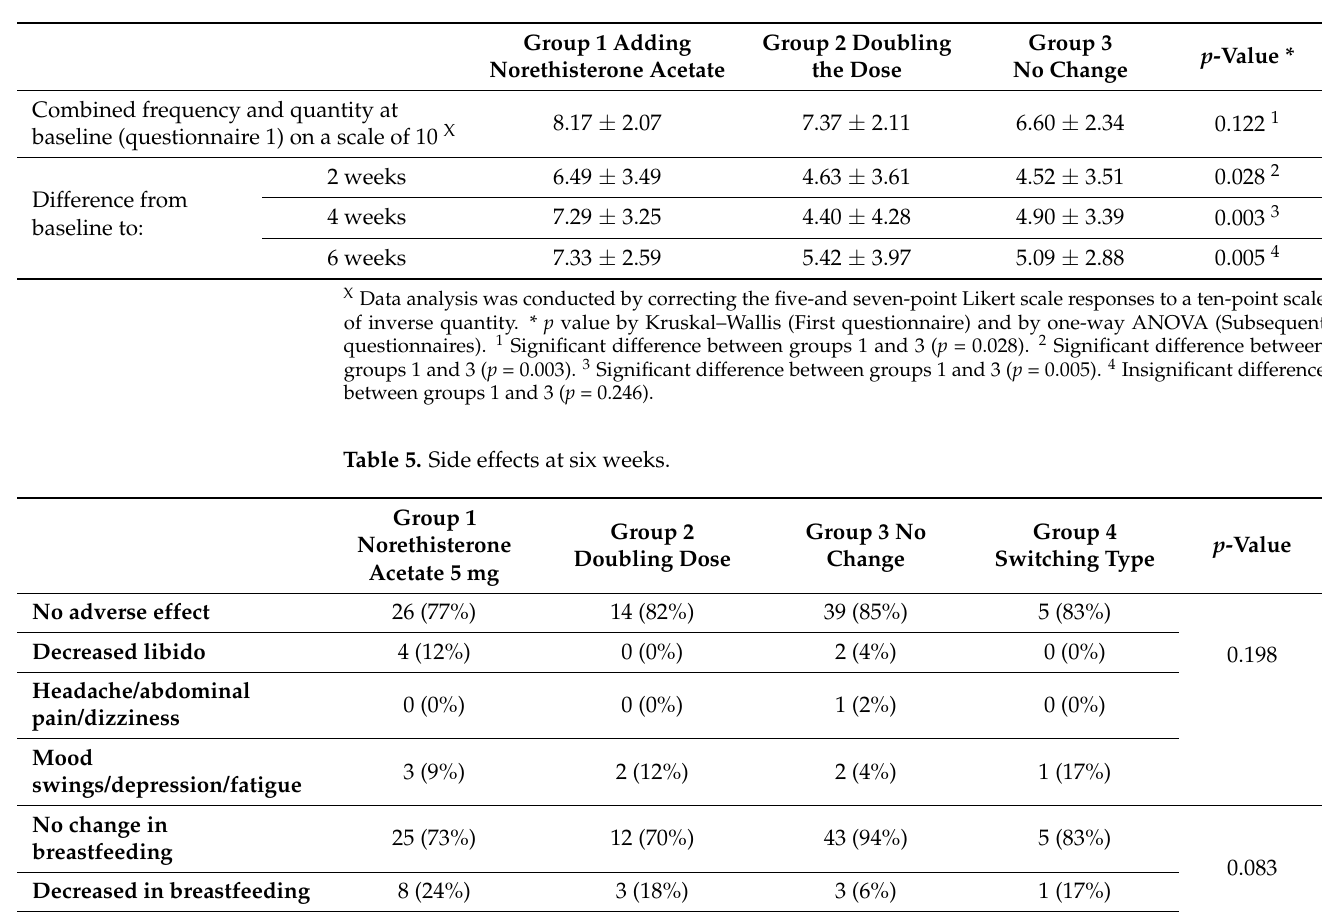
Table 4. Comparison of combined frequency and quantity.